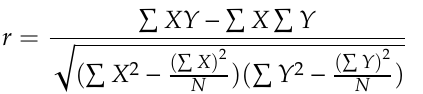
Figure 13. Priority while weights set as [0,0.5,0.5] in test 8.